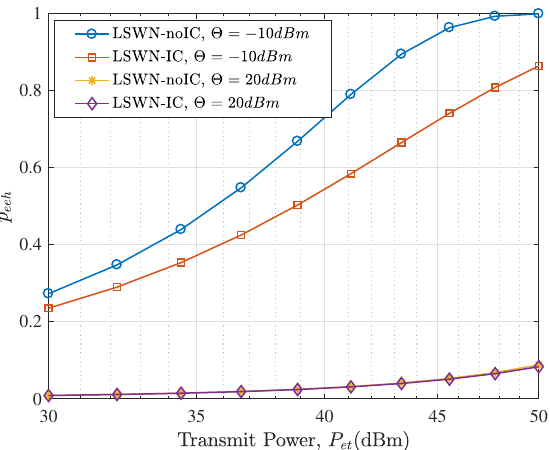
Figure 11. Effective energy harvesting probability versus transmitting power with α = 4, d = 2 and λ t = 0.001.